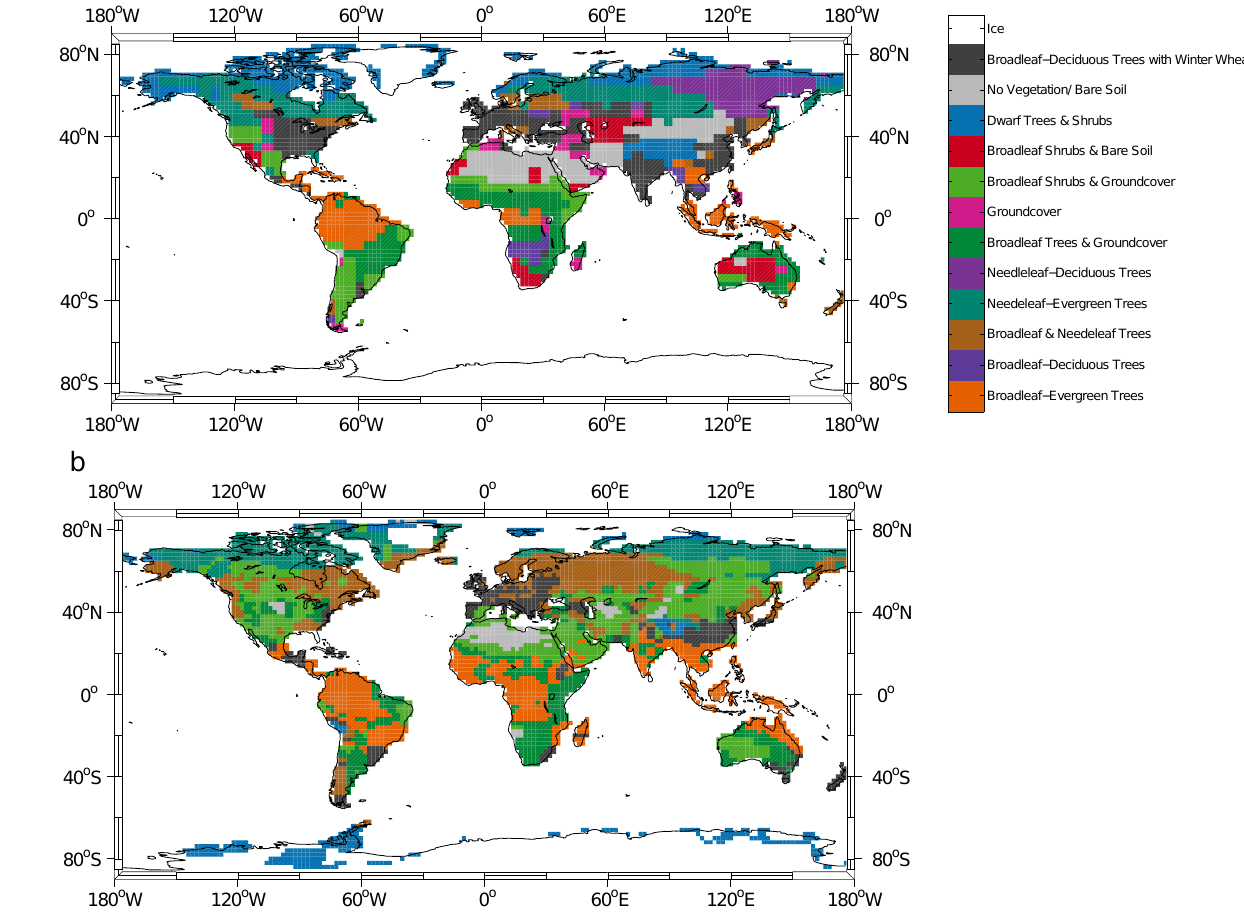
Fig. 4. Boundary conditions. Re-classified mega-biome distribution of Dorman and Sellers (1989) for (a) pre-industrial, and (b) mid-Pliocene vegetation input files.